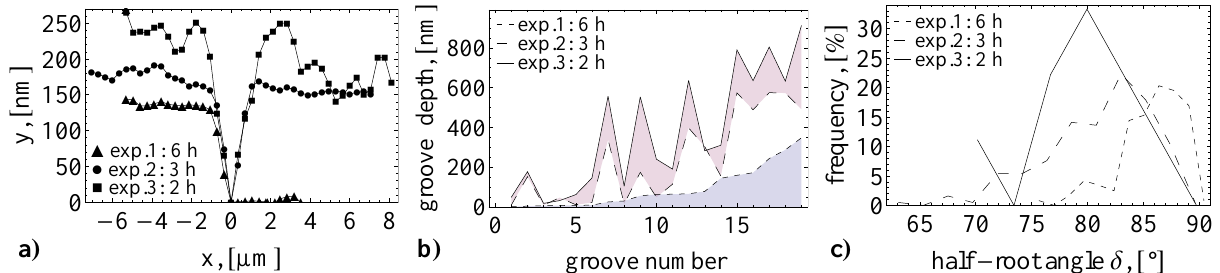
Figure 9. Evolution of (a) groove profiles, (b) groove depth and (c) half-root angle δ in sequential experiments at 392 ◦ C with a cumulative duration of 11h (P40 1–3, see Table 2). In (b) the grooves are ordered by their size after the first annealing step; while most grooves deepen with time the evolution of individual grooves differs considerably. The most frequent half-root angle ( c , see also Table 2) decreases with the number of annealing steps. The total number of angles measured is 128, 192, and 12 for the three subsequent experiments.